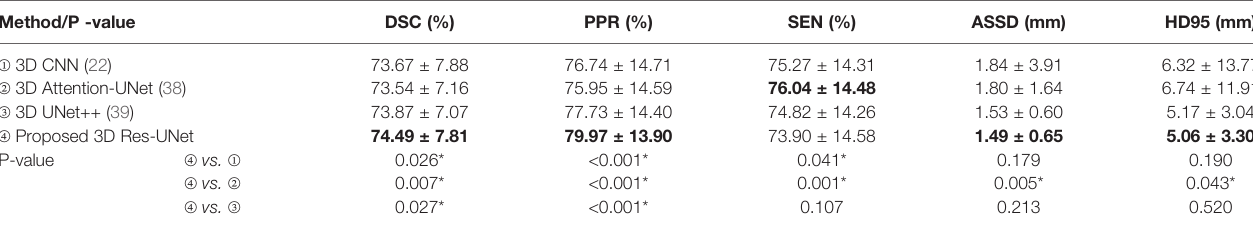
TABLE 2 | Quantitative comparison of different backbone models for GTV segmentation performance, including mean DSC, PPR, SEN, ASSD and HD95 with standard deviation. Method/P